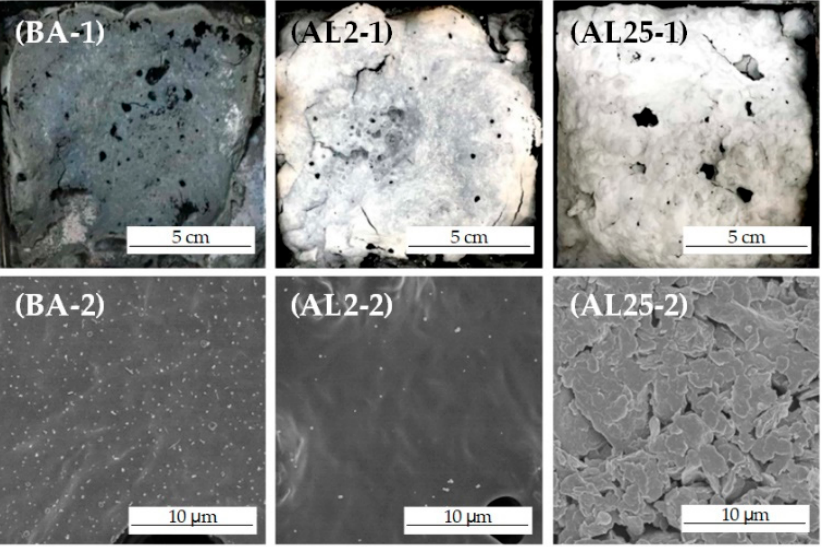
Materials 2019 , 12 , x FOR PEER REVIEW